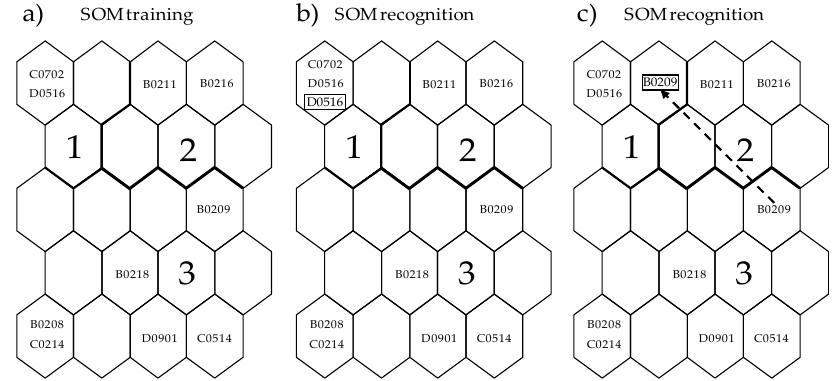
Figure A1. The process of SOM recognition. The SOM training results ( a ); individual (D0516) was recognized as having no cluster change ( b ); while individual (B0209) was recognized as having undergone a cluster change from cluster III to I ( c ).